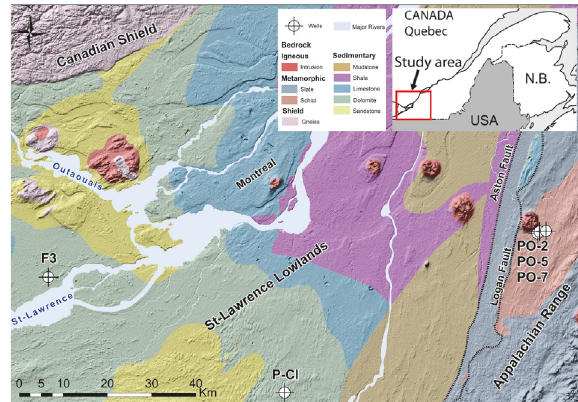
Figure 1: Location of wells in the current study and geological